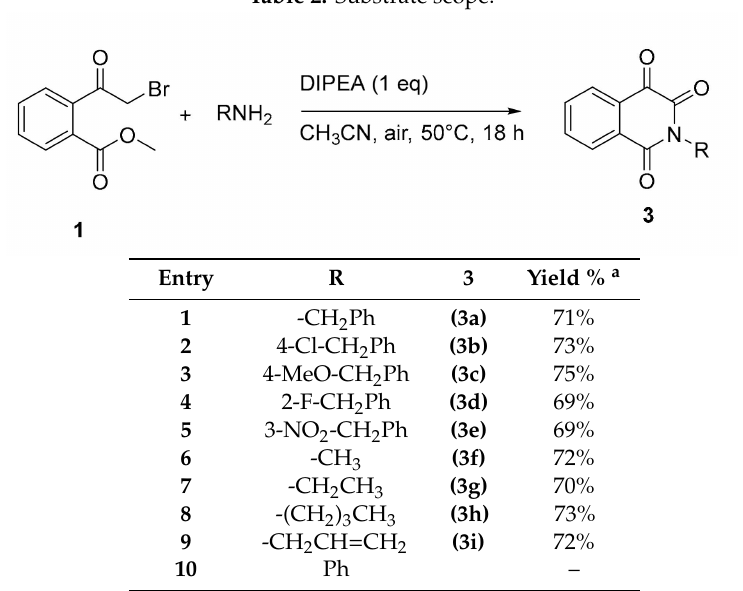
Table 2. Substrate